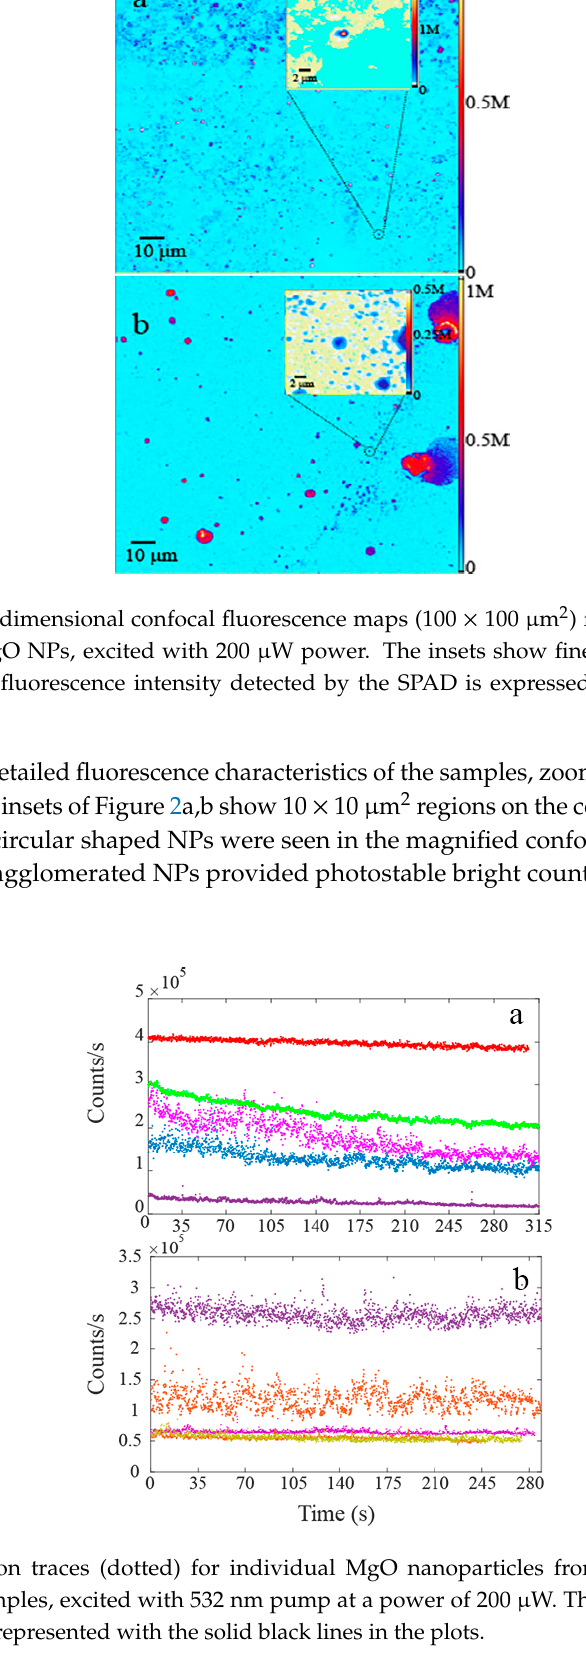
Figure 3. Emission traces (dotted) for individual MgO nanoparticles from ( a ) commercial and ( b ) ball-milled samples, excited with 532 nm pump at a power of 200 μ W. The average background counts of 10 k are represented with the solid black lines in the plots.